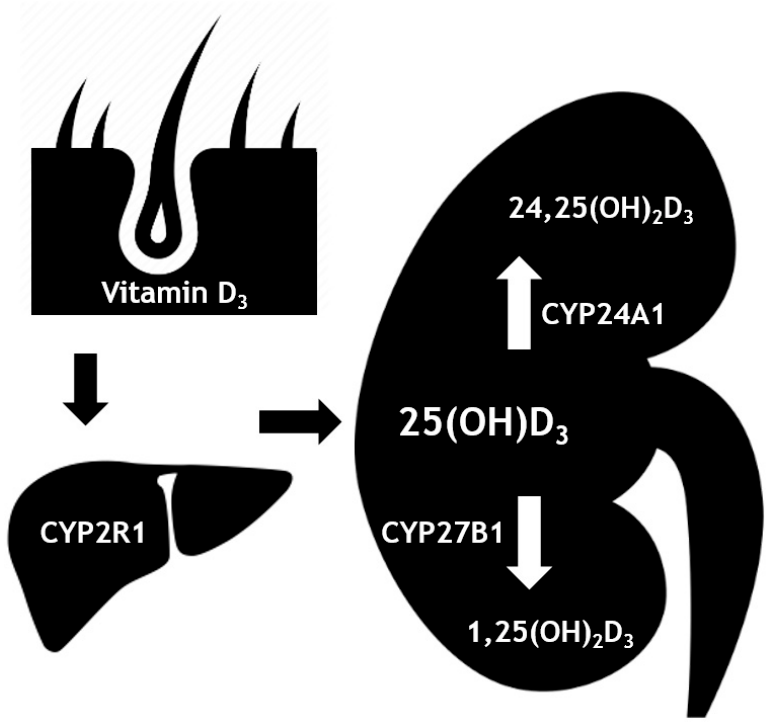
Figure 1. Metabolism of vitamin D. Vitamin D 3 (cholecalciferol) is produced in the skin when exposed to sunlight. The hepatic enzyme CYP2R1 then converts this into 25(OH)D 3 (calcifediol). In the kidneys, 25(OH)D 3 can be converted into the active form, 1,25(OH) 2 D 3 (calcitriol), by CYP27B1 (1- α - hydroxylase). In the kidneys, CYP24A1 (24-hydroxylase) can catabolize the 25(OH)D 3 into 24,25(OH) 2 D 3.